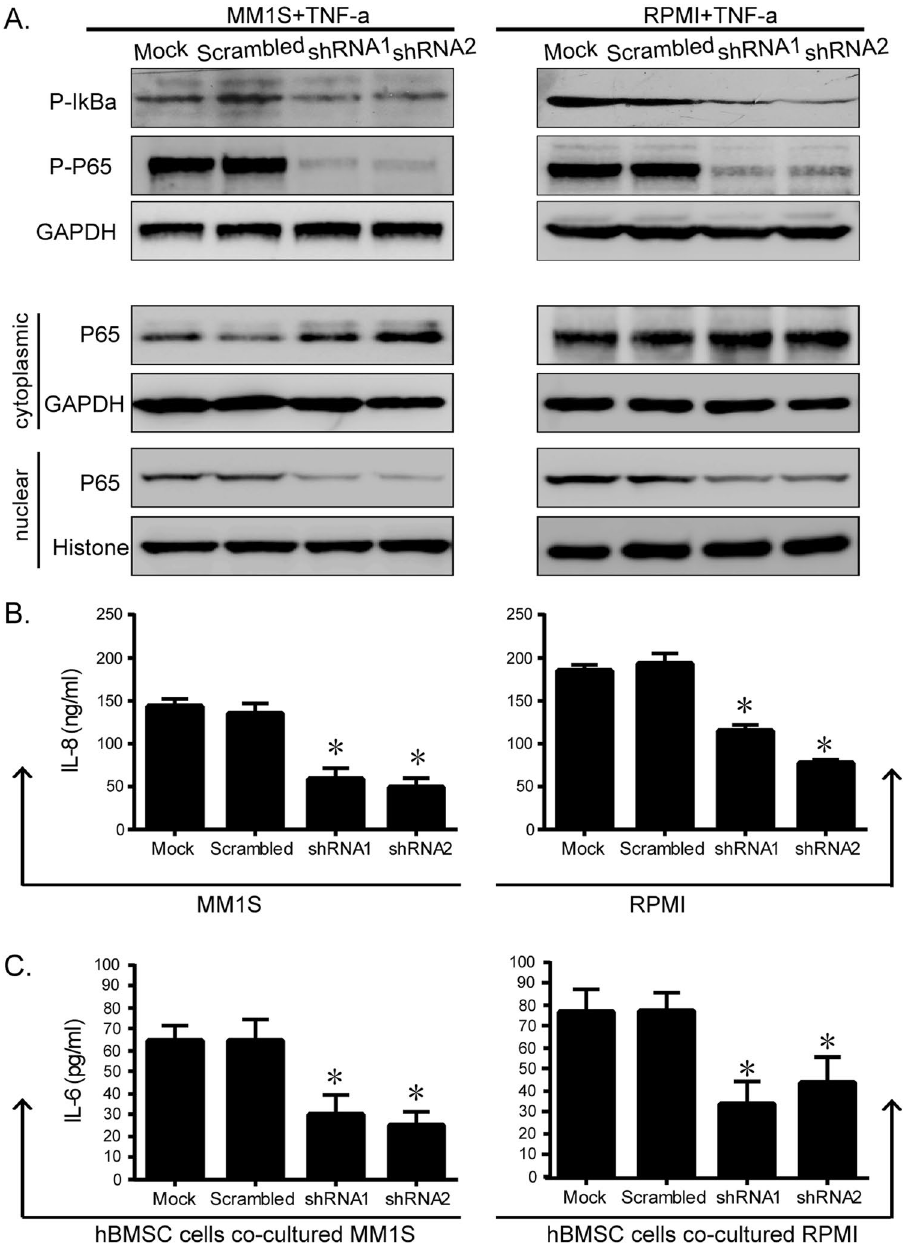
Figure 3. The activities of NF- κ B and secretion of IL-8 were significantly repressed in H19 silenced MM cells. Secretions of IL-6 by hBMSCs were significantly decreased when co-cultured with H19 silenced MM cells. ( A ) Phosphorylated I κ B α and P65, as well as cytosol and nucleous protein levels of P65 in H19 silenced MM cells were detected by western blot. GAPDH expression was used to normalize for equal loading. TNF- α (100 mg/ mL for 24 h) was used to induce NF- κ B activation. Secretions of IL-8 by MM cells ( B ) and IL-6 by hBMSCs co- cultured with MM cells ( C ) were detected by ELISA. ( * P < 0.01, Figure is representative of 3 experiments with similar